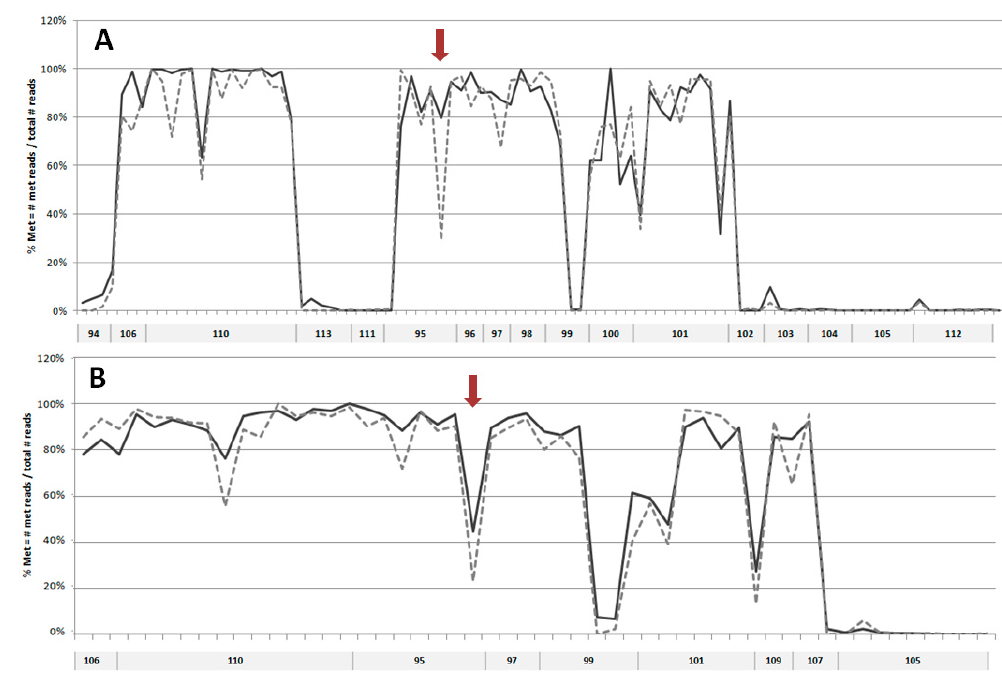
Figure 1. Targeted next-generation sequencing NGS analysis of CpG methylation in selected regions of EDC in DNA from undifferentiated and differentiated primary keratinocytes (NHEK). ( A ) Analysis performed on DNA from cells derived from an individual donor. ( B ) Analysis of highly methylated sequences shown in (A) in DNA from cells obtained from many donors. Sequences 109 and 107 could be read only in analysis B, and sequences 98 and 100 in analysis A. Solid line—undifferentiated keratinocytes; dashed line—differentiated keratinocytes. Arrows indicate the demethylated cytosine residue in sequence no. 95.